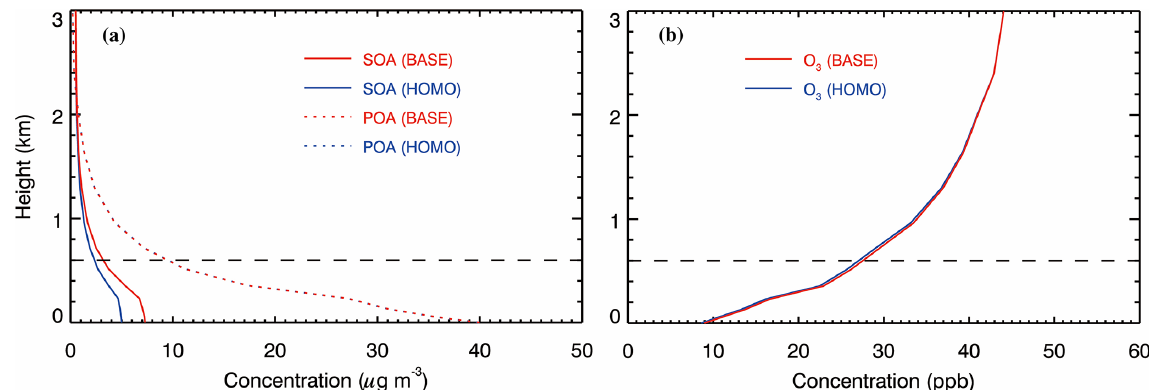
Figure 6. Vertical distribution of (a) SOA and POA and (b) O 3 concentrations averaged from 9 to 26 January 2014 at the IRSDE site in Beijing. Red and blue lines represent the BASE and HOMO cases, respectively.